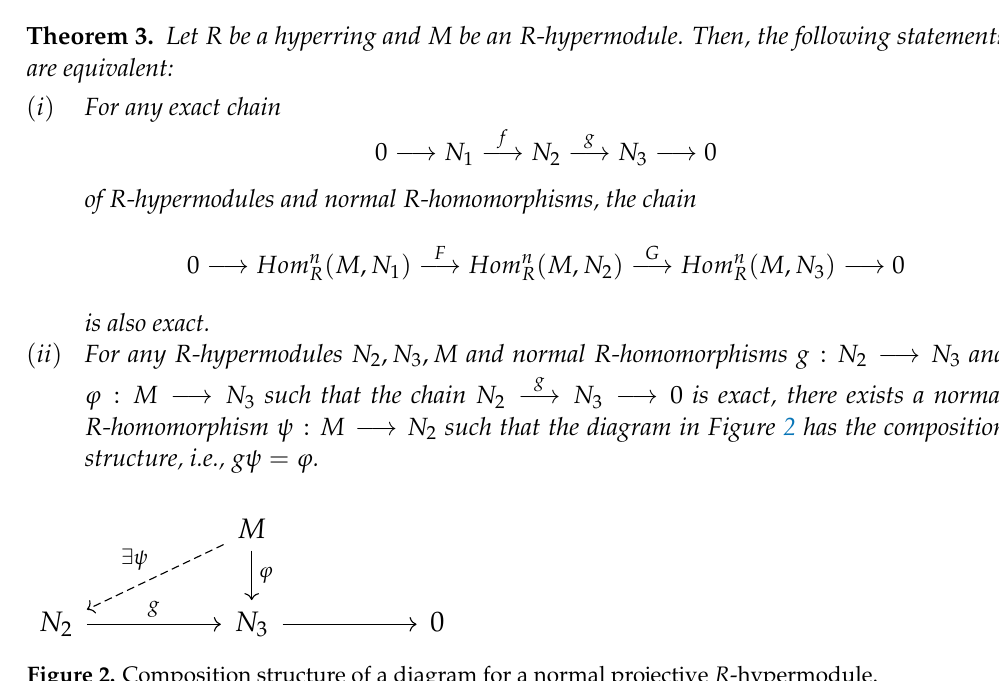
Figure 3. Composition structure of a diagram for a normal injective R -hypermodule, using hyperide- als